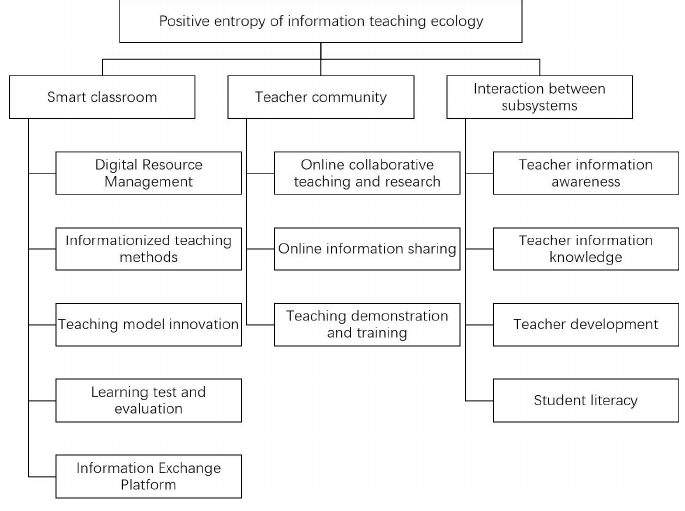
Fig. 2 The positive entropy index system of information teaching ecology